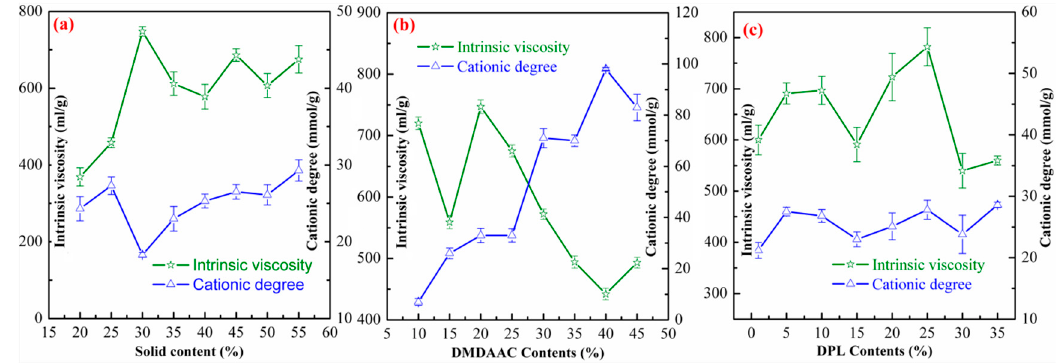
Figure 1. Effect of ( a ) solid content, ( b ) DMD content, and ( c ) DPL content on polymerization. DMD: dimethyl ammonium chloride; DPL: dodecyl polyglucoside.